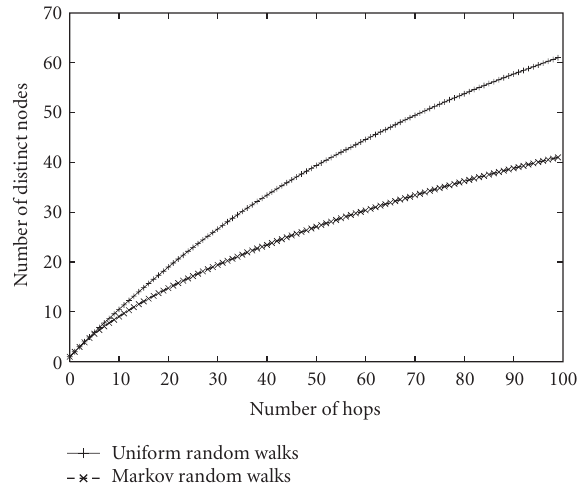
Figure 2: Markov random walks discover a smaller number of nodes than uniform random walks do.